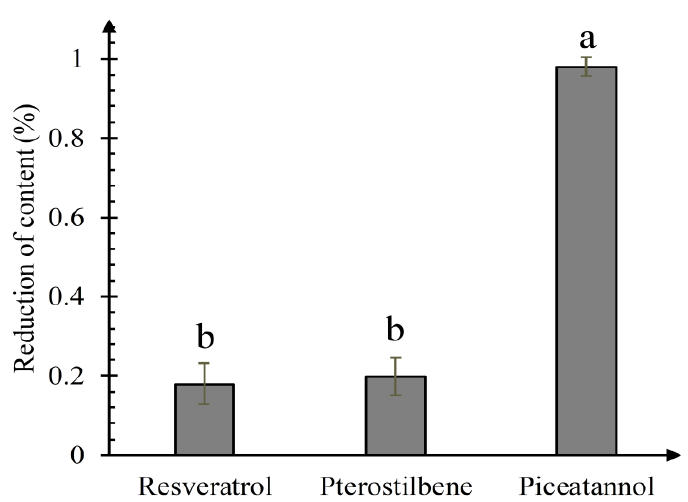
Figure 4. Changes of three stilbene contents in the prossess of quenching 1 O 2 . The values are means of three replicates and their standard errors. Means with different letters are significantly different according to Duncan’s multiple-range test ( p < 0.05).